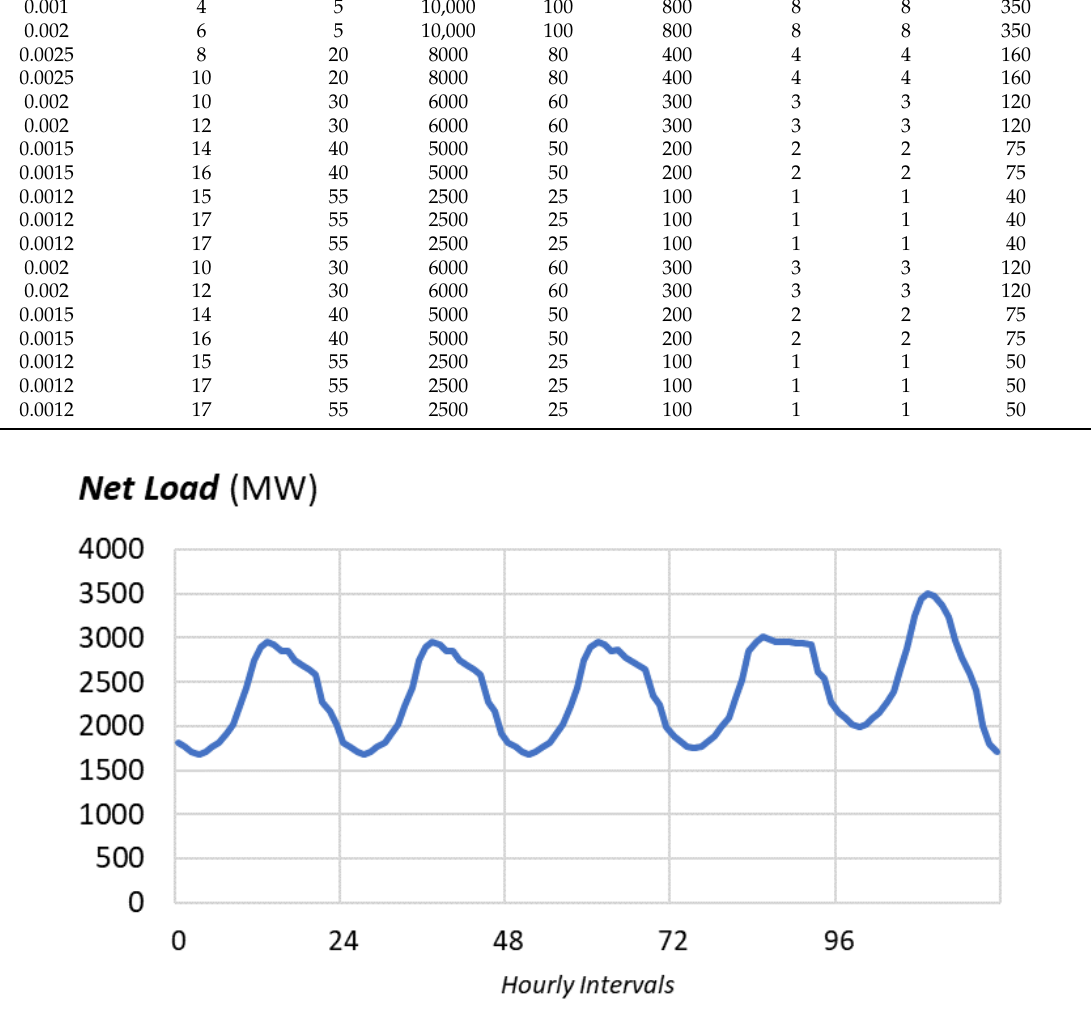
Figure 1. Net-load demand (MW) for 120 weekday hours.